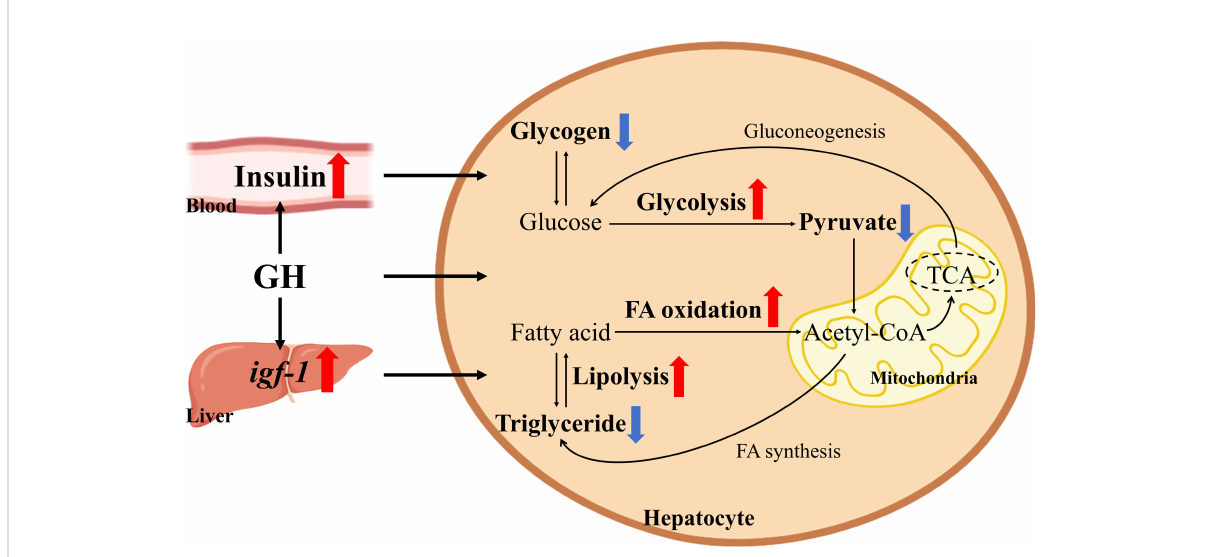
FIGURE 10 Schematic of the effects of GH overexpression on glucose and lipid catabolism in common carp. Red arrows indicate upregulated genes, proteins, or pathway. Blue arrows indicate decreased